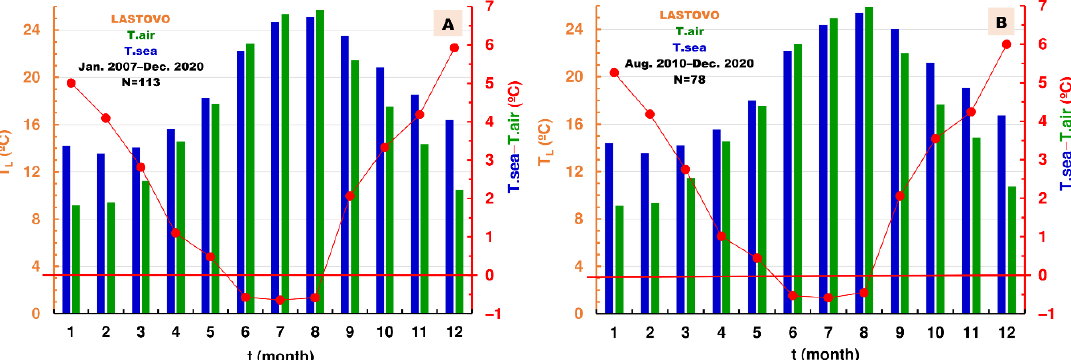
Figure 14. Histograms of the average values of the mean monthly sea surface temperatures (blue) and air temperature (green) and their differences (red colour) observed at Lastovo from January 2007